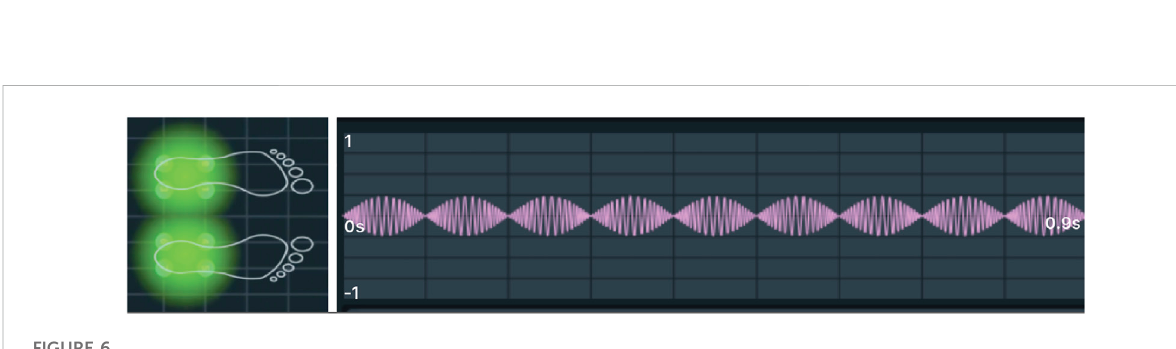
Frontiers in Virtual